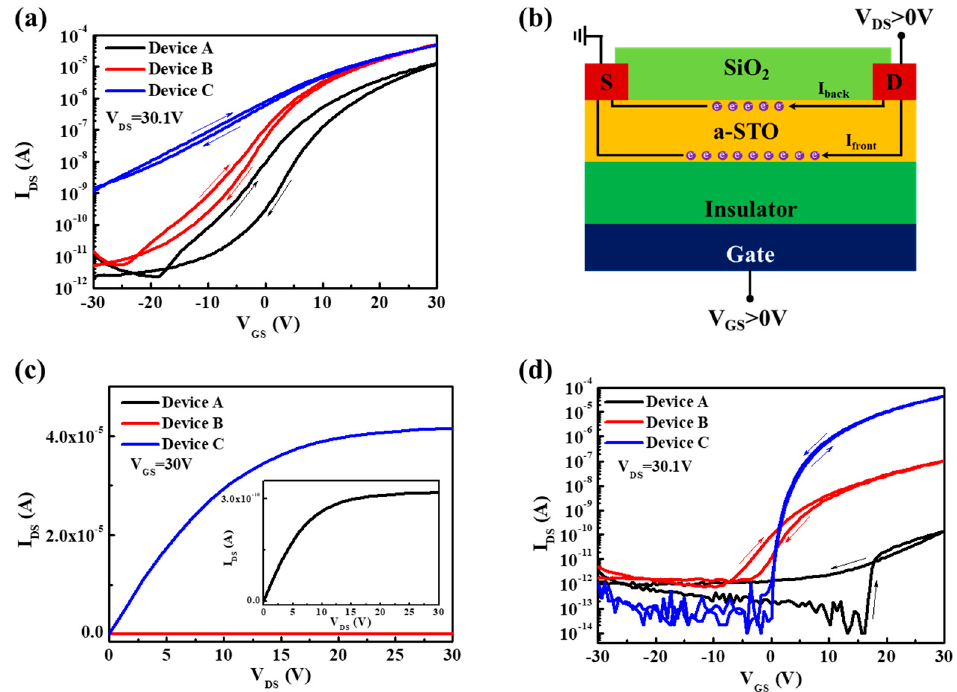
Figure 2. ( a ) The transfer characteristic curves of as-deposited a-STO TFTs when V DS was fixed at 30.1 V; ( b ) Schematic of current paths of as-deposited a-STO TFT; ( c ) The drain current of a-STO TFTs annealed at 450 °C for 0.5 h in argon ambient when V GS was fixed at 30 V; ( d ) The transfer characteristic curves of a-STO TFTs annealed at 450 °C for 0.5 h in argon ambient when V DS was fixed at 30.1 V.